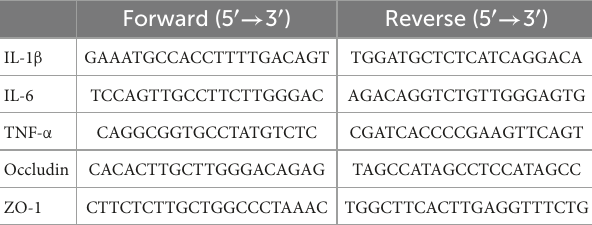
TABLE 2 Sequences of primers for